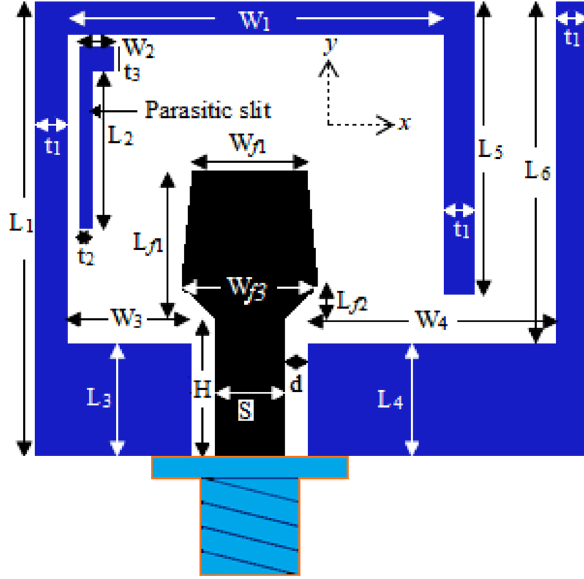
Figure 1. Schematic diagram of the proposed CPW-fed